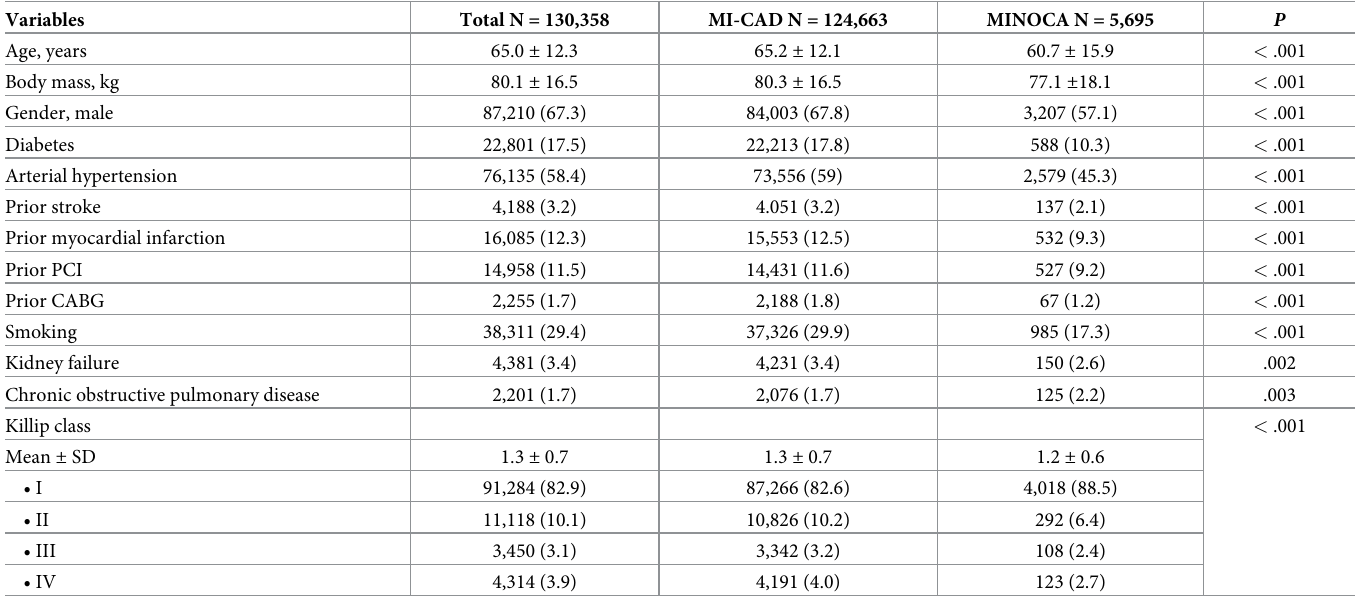
Table 1. Clinical characteristics at baseline in STEMI patients treated with PCI according to presence of significant coronary atherosclerosis (MI-CAD vs. MINOCA).